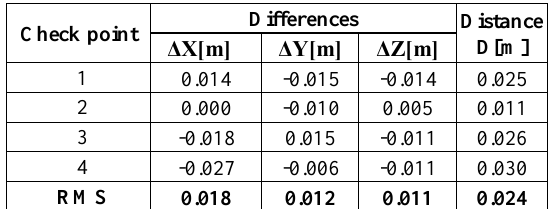
Table 4. The residuals of the artificial CPs after georeferencing the point cloud using the minimum number of control points